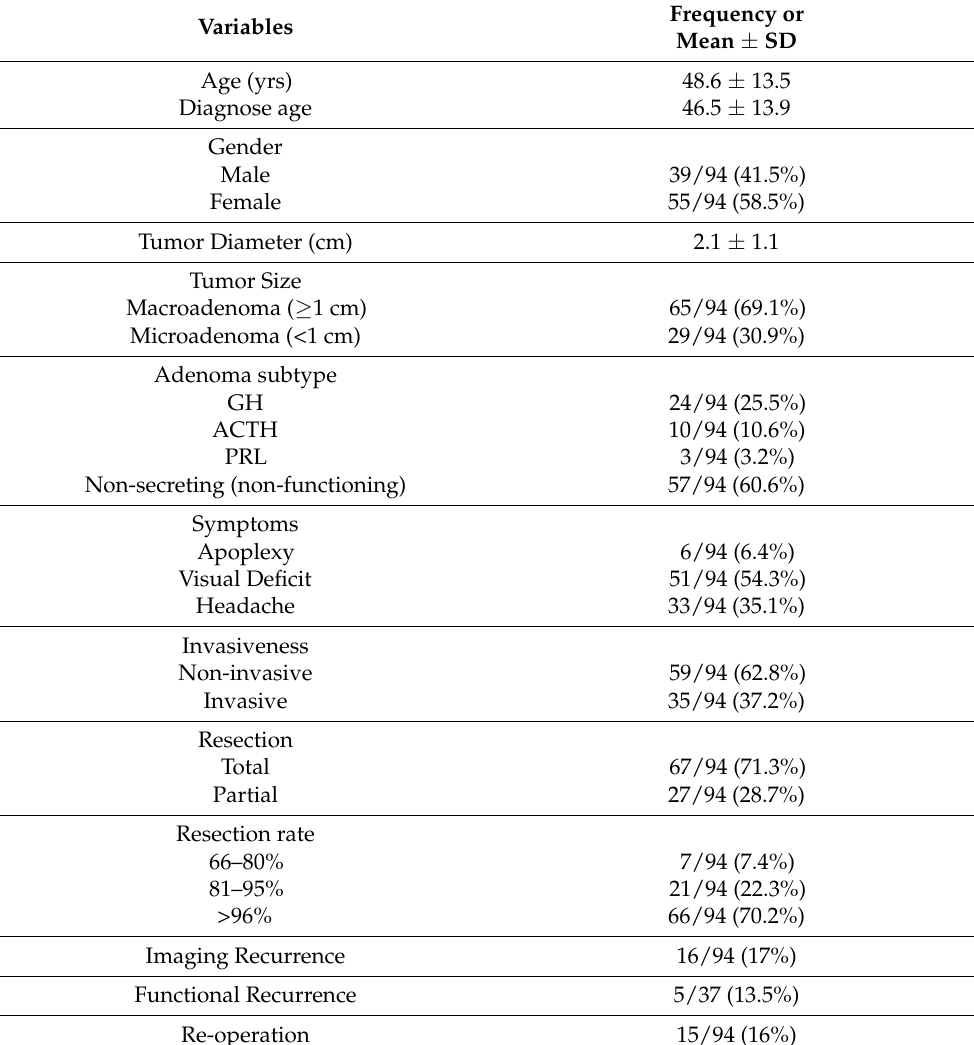
Table 1. Baseline characteristics of the included